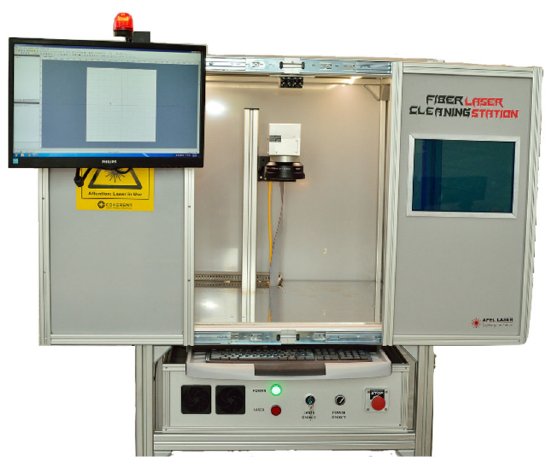
Figure 5. Experimental setup for the laser surface polishing treatment.